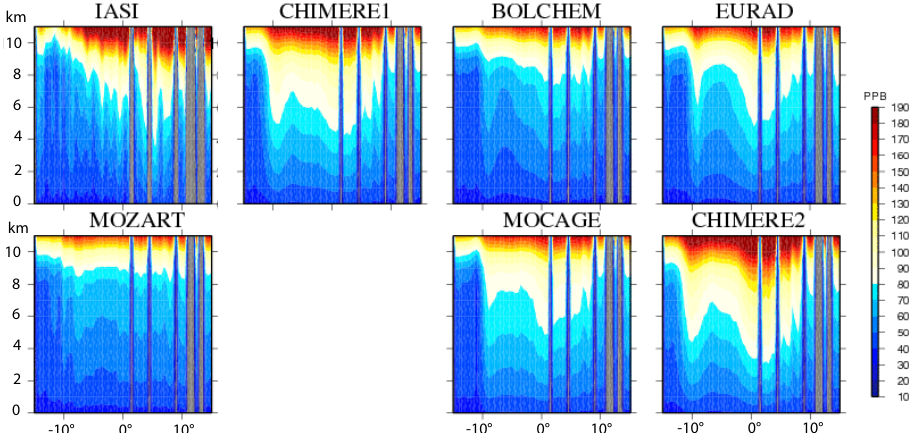
Fig. 10. Vertical cross section through IASI ozone concentrations (in ppb) and different model simulations at 48 ◦ N for 8 June 10:00GMT.